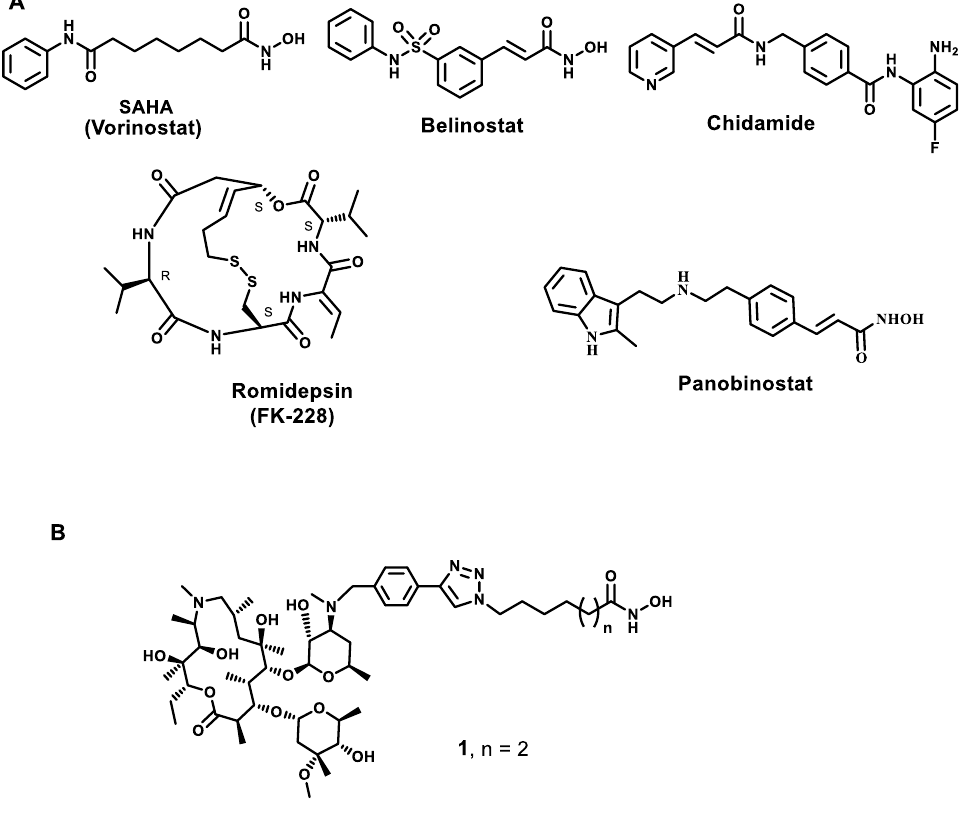
Figure 1. ( A ) Structures of currently approved HDACi (note: optical rotation at Romidepsin chiral centers are indicated with R and S). ( B ) Structure of a representative lead macrolide-based HDACi.